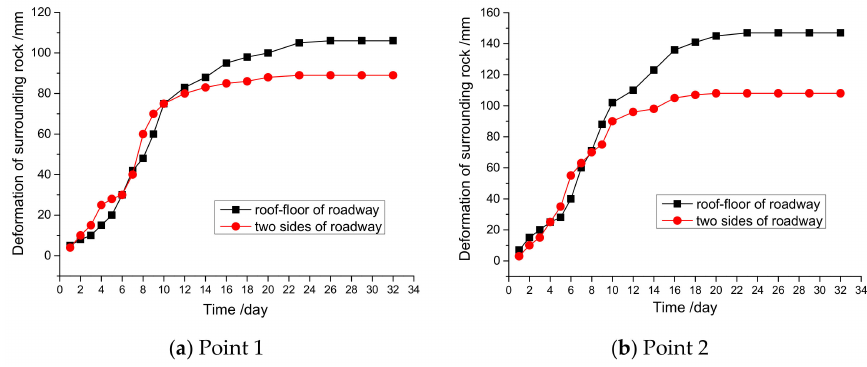
Figure 25. The deformation of the surrounding rock with time in the ventilation